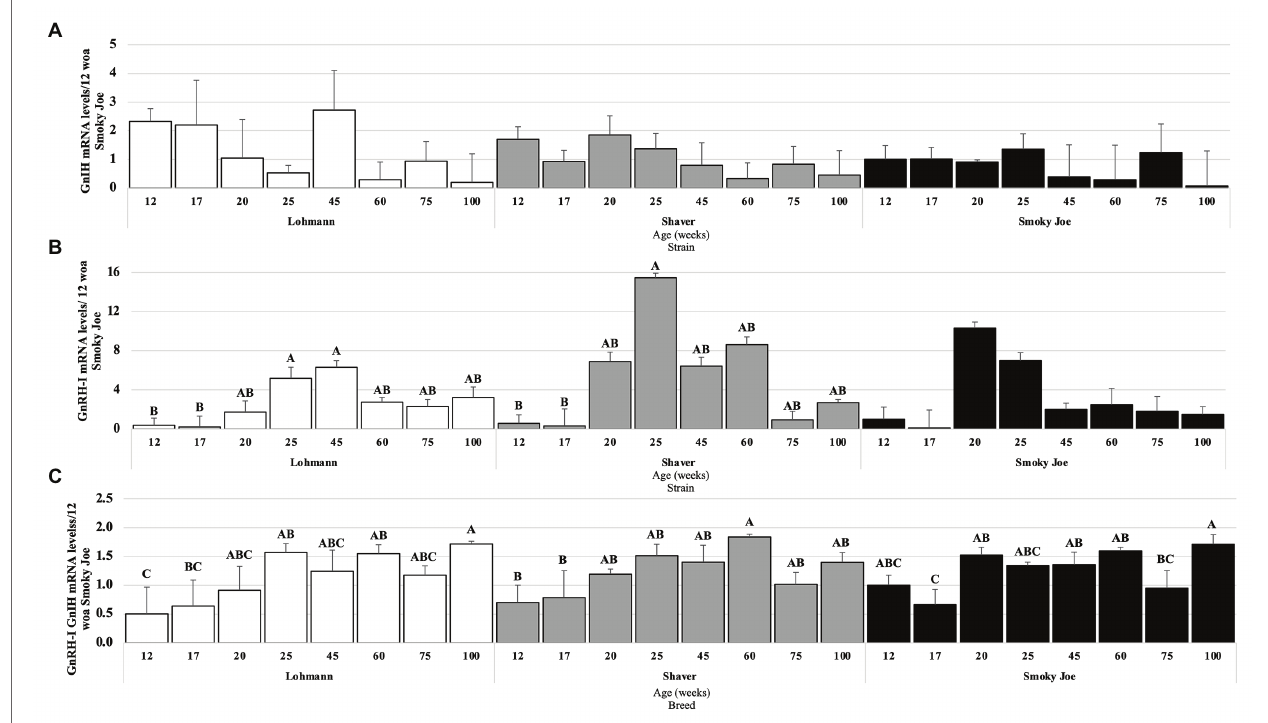
FIGURE 7 | Gonadotrophin-Inhibiting Hormone (GnIH; A ) and Gonadotrophin-Releasing Hormone I (GnRH-I; B ) mRNA expression levels in Lohmann, Shaver, and Smoky Joe hens at 12, 17, 20, 25, 45, 60, 75, and 100 woa. (C) Ratio between GnRH-I and GnIH mRNA levels. p -values for the sources of variation of age by strain: (A) Lohmann, p = 0.0766; Shaver, p = 0.1713; and Smoky Joe, p = 0.0941. (B) Lohmann, p = 0.0155; Shaver, p = 0.0026; and Smoky Joe, p = 0.0684. (C) Lohmann, p = 0.0025; Shaver, p = 0.0037; and Smoky Joe, p = 0.0006. A,B,C Data points lacking the common superscript differ significantly within the ages of each strain, while no superscript did not differ from any other time point in that